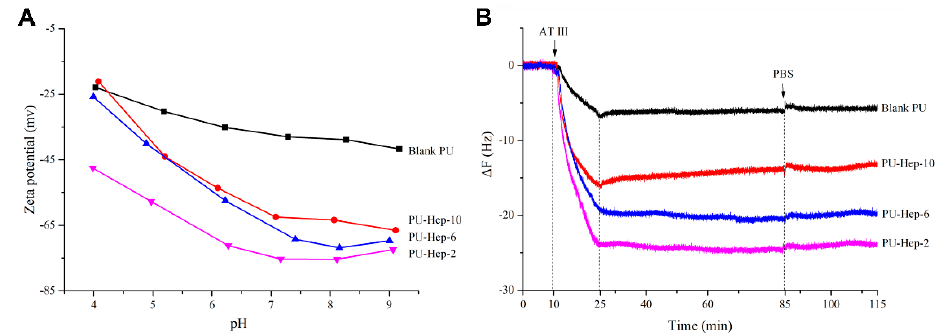
Figure 3. ( A ) Zeta potential at various pHs and ( B ) quartz crystal microbalance (QCM) measurements for PU and heparinized PU films.